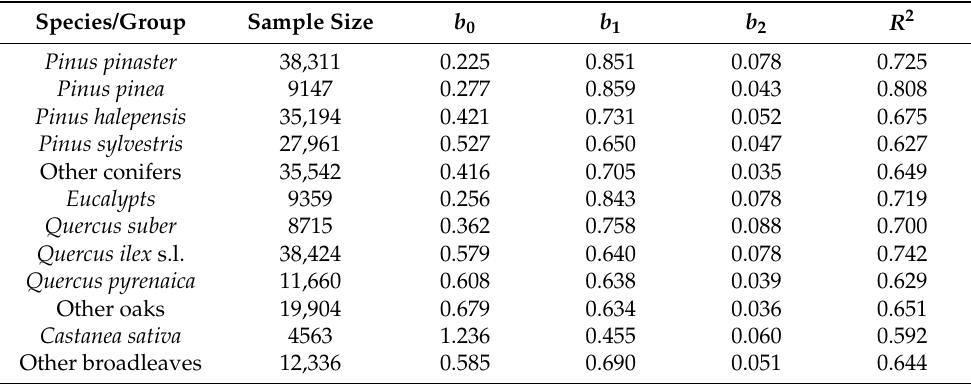
Figure 8. Crown Length (CL) of a 10 m tall tree (HT = 10 m) as a function of reference distance to neighbor tree (DIST): conifers and eucalypts ( a ), and oaks and other broadleaves ( b ). The fitted equation for all species or group of species for Crown Diameter (CD) shows the relations between the Diameter at Breast Height (DBH) and the DIST as in Equation (15). The results for the coefficients of b 0 , b 1 and b 2 for the species or group of species considered for the Iberian Peninsula are shown in the Table 3. Table 3. Parameter estimates and coefficients of determination for the species of trees or groups of species obtained fitting Equation (15) to estimate Crown Diameter (CD) from stem Diameter at Breast Height (DBH) and reference Distance